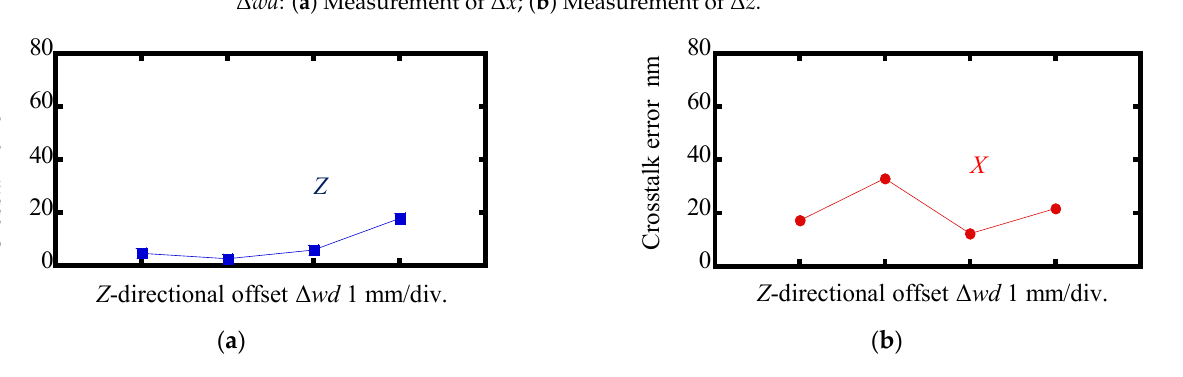
Figure 12. Variations in amplitudes of the interpolation errors as the change in the Z -directional offset Δ wd : ( a ) Reading of Δ z when the scale was moved along the X -direction in a range of ±1.5 mm; ( b ) Reading of Δ x when the scale was moved along Z -direction in a range of ±1.5 mm.